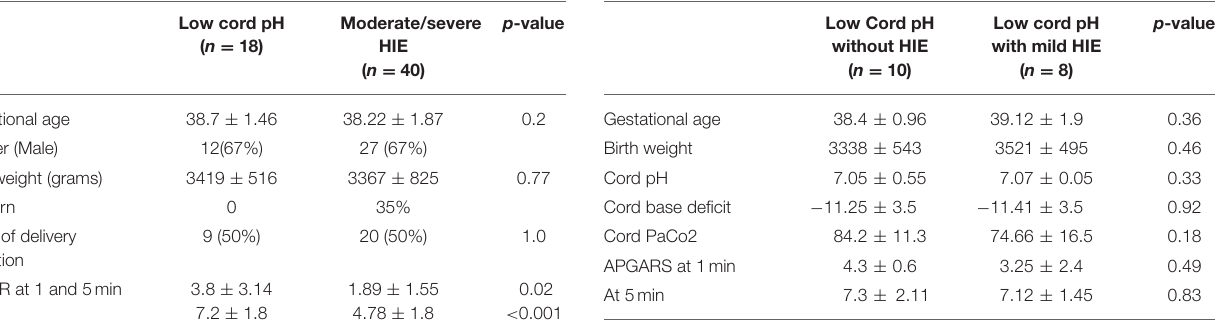
TABLE 1 | Demographic data. TABLE 2 | Demographic